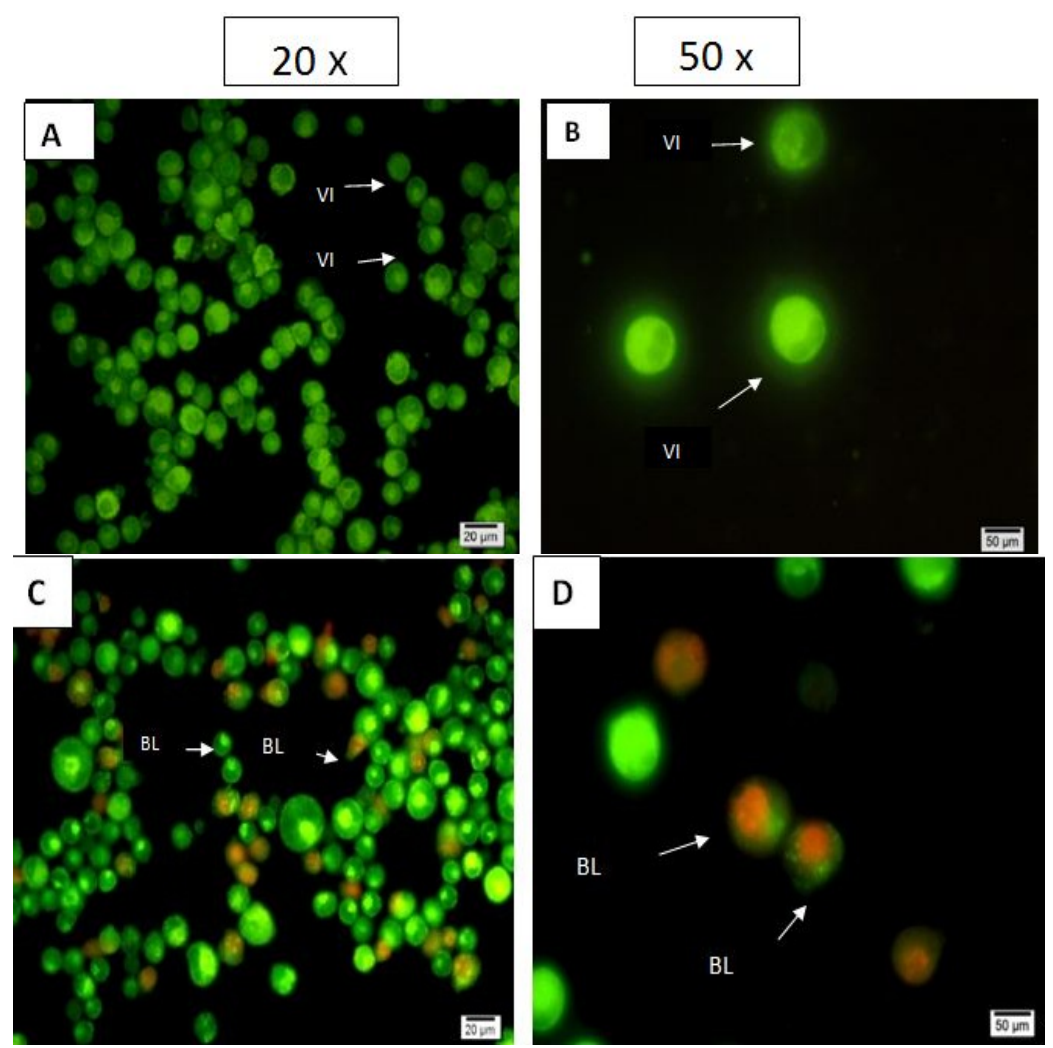
Figure 2. Fluorescent micrographs of acridine orange and propidium iodide double- stained CEMss cells. Cells were treated at the IC of thymoquinone in a time-dependent manner. 50 Cells were cultured in RPMI 1640 media maintained at 37 °C and 5% CO . 2 ( A , B ) Untreated cells after 72 h showed normal structure without prominent apoptosis and necrosis. ( C , D ) Early apoptosis features were seen after 24 h representing intercalated acridine orange (bright green) amongst the fragmented DNA, (E, F) Blebbing and orange color representing the hallmark of late apoptosis were noticed in 48 h treatment, ( G , H ) bright red colored secondary necrosis were visible after 72 h. VI: viable cells; BL: blebbing of the cell membrane; LA: late apoptosis; SN: secondary necrosis. Images are representative of one of three similar